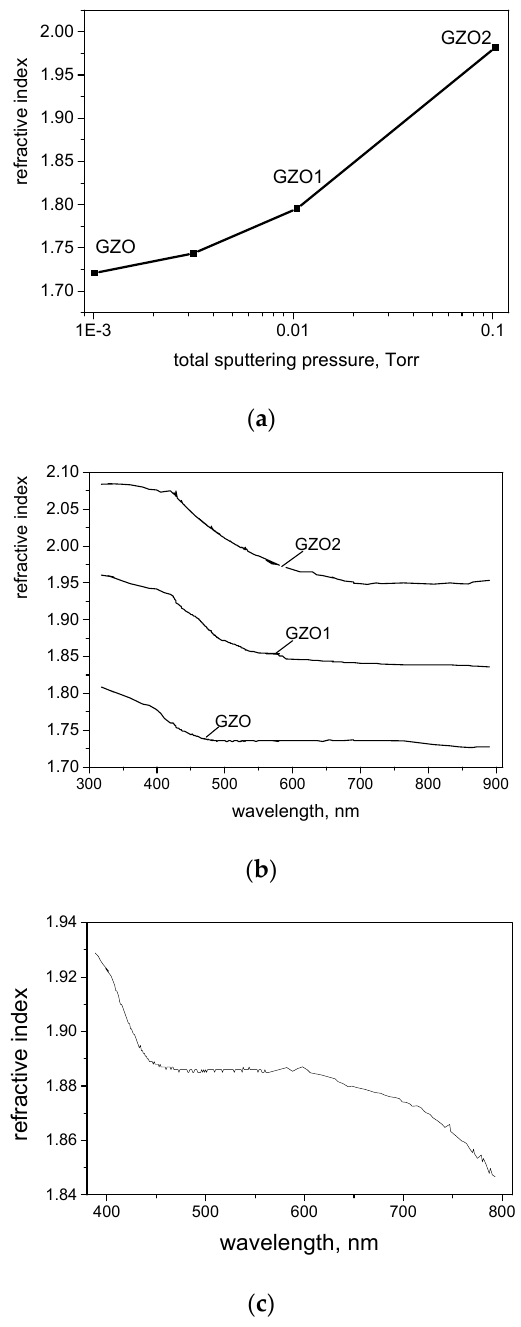
Figure 1. Refractive index of GZO sputtered at different total sputtering pressures due to additional target oxidation: ( a ) in the IR region; ( b ) in the whole spectrum range from UV to NIR. Sample GZO corresponds to non-additional oxidation, GZO1—to 10% additional oxidation, GZO2—to 20% additional oxidation; ( c ) refractive index of the ITO film